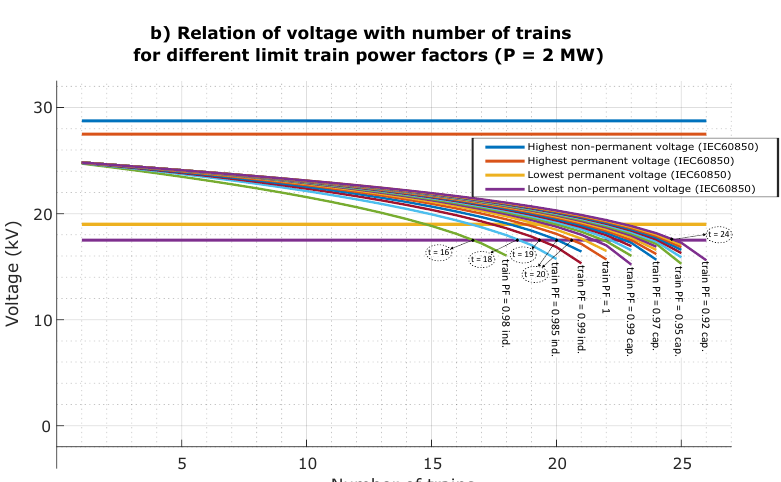
Figure 18. Relation of number of trains (PF = 0.98 ind.) with lower voltage in line: ( a ) variation of active power in each train, for fixed train PF limit (0.98 cap.); ( b ) variation of compensation, for fixed train active power of 2